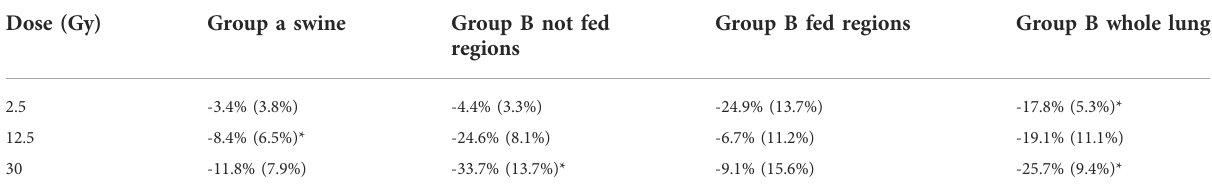
TABLE 2 Summary of percent changes in vessel volume. Values in table are entered as average (standard deviation) of the fi ve swine in each group. Statistically signi fi cant values ( p < 0.05) are denoted with a *.